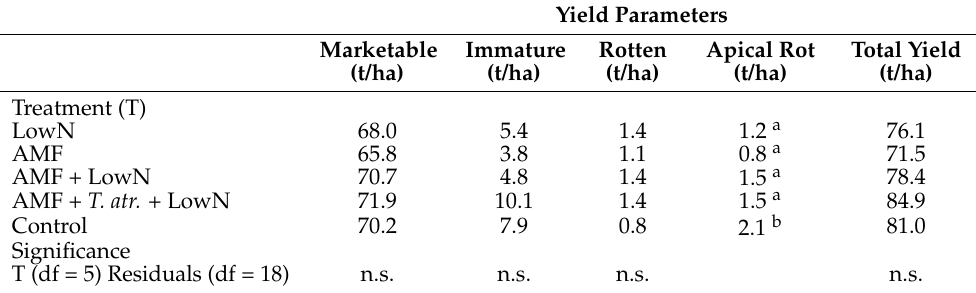
Table 1. Yield parameters for tomato grown under low nitrogen fertilization regimen, treated with different biostimulants at the site with sub-optimal soil fertility. The data were elaborated by one-way analysis and Duncan test.